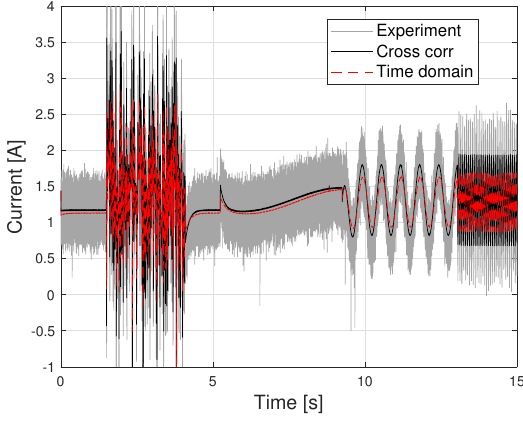
Figure 14. Current time history.